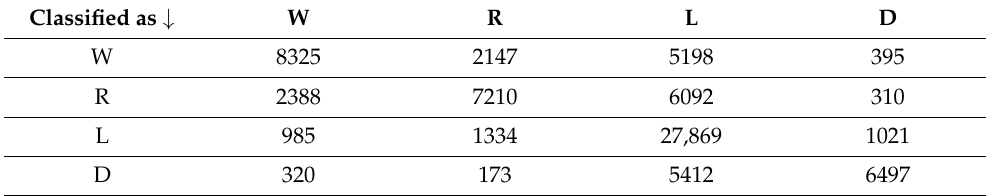
Table A2. Confusion matrix of the classification result in the test set of